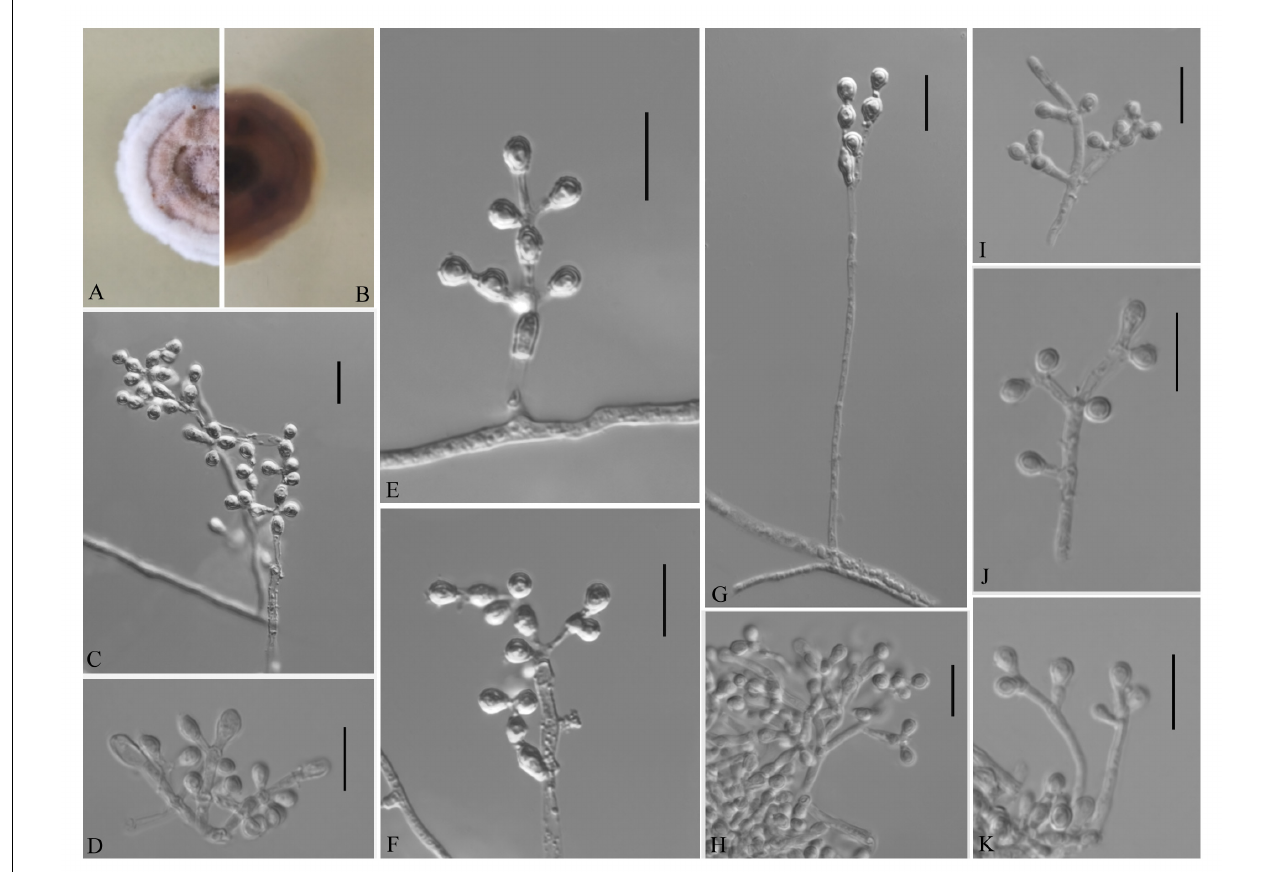
FIGURE 4 | Pseudogymnoascus guizhouensis [from ex-holotype Institute of Fungus Resources, Guizhou University (GZUIFR) 376.1]. (A,B) The front and reverse of a P. guizhouensis colony on PDA after 14 days at 25 ◦ C. (C–K) Conidiophores and conidia. Scale bars = 10 µ m.